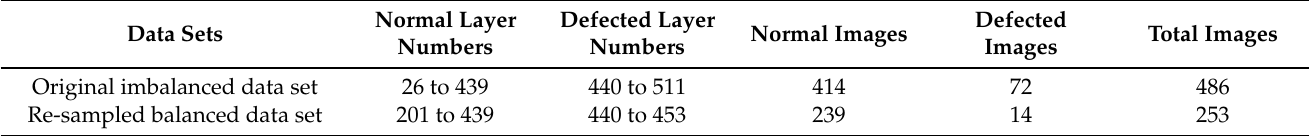
Table 1. Number of defected and non-defected images in different data